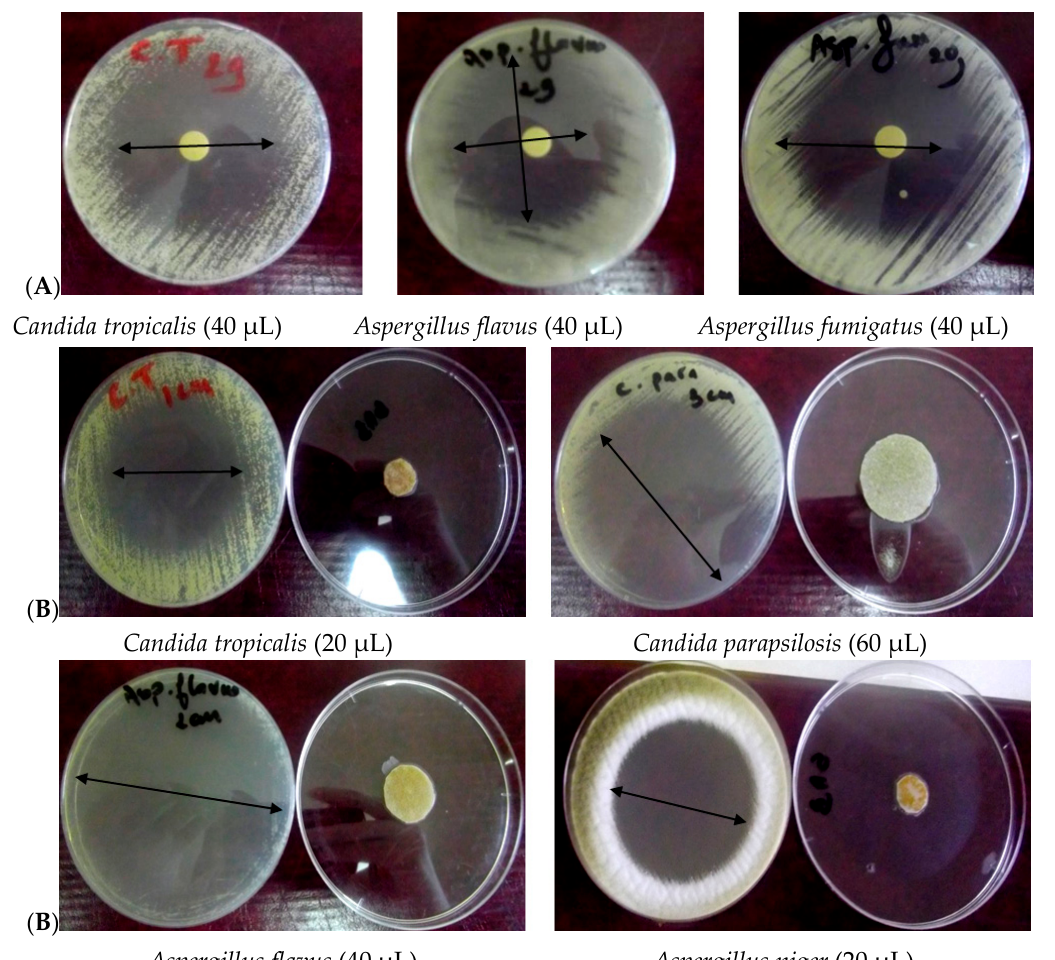
Figure 3. Inhibitory effect of Thymus vulgaris against fungal strains: disc diffusion ( A ) versus vapor diffusion ( B ) methods.